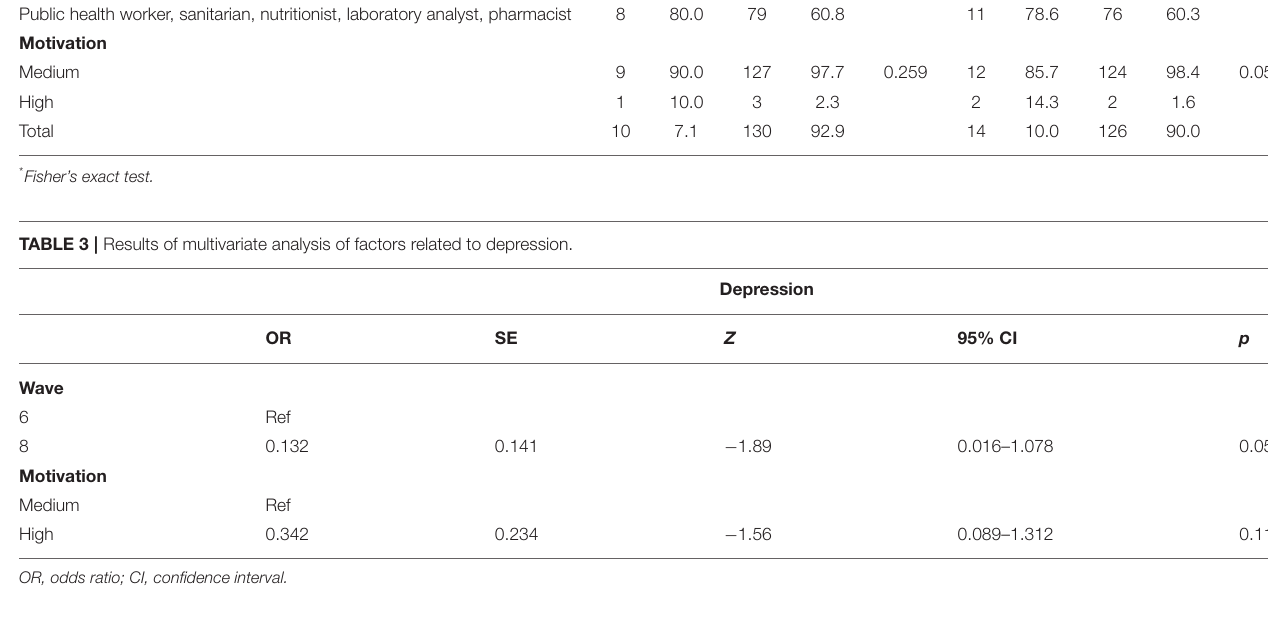
TABLE 4 | Results of multivariate analysis of factors related to psychological